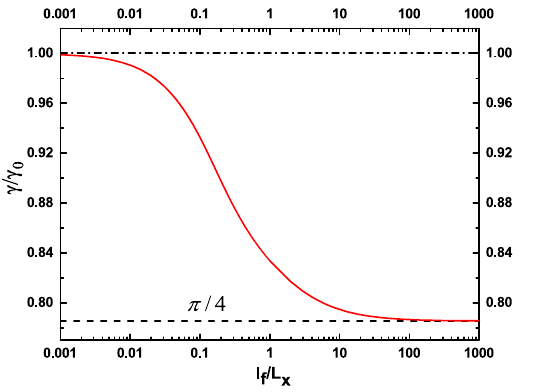
2 F2 . γ γ / versus l L / , where γ ∆ = − E 1 /4 approaches π /4 in the 0 0 0 f x